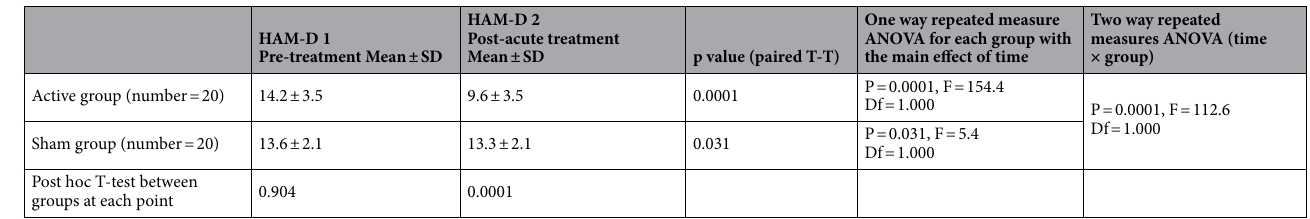
Table 5. Effect of HF-rTMS on the Hamilton depression rating scale pre-treatment (HAM-D1), and post- acute treatment (HAM-D2).